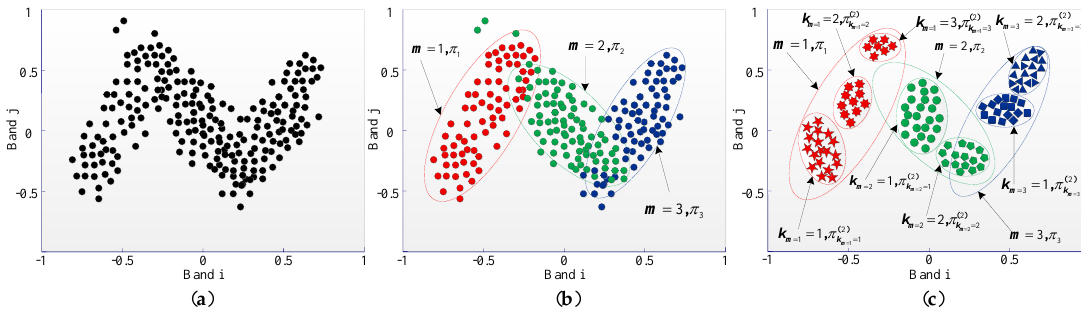
Figure 1. ( a ) A scatterplot of HSI samples over two spectral bands. ( b ) Illustration of the MFA model with each ellipse representing a Gaussian component. MFA has three components colored red ( m = 1), green ( m = 2) and blue ( m = 3). Their mixing proportions are given by π m . ( c ) Illustration of DMFA model with each ellipse representing a Gaussian component. The number of components and mixing proportions of the first layer of DMFA are the same as MFA. For the red component, we further learn a second layer of DMFA with three components. For the green and blue components, both of them are learned a second layer of DMFA with two components, respectively. We also introduce the second layer component indicator ( 2 ) variable k m = 1,2,..., K m and mixing proportions π m , where K m is the total number of the second layer components associated with the first layer component m . K m is specific to the first layer component and need not be the same for all m . In this example, K 1 = 3, K 2 = 2 and K 3 = 2.